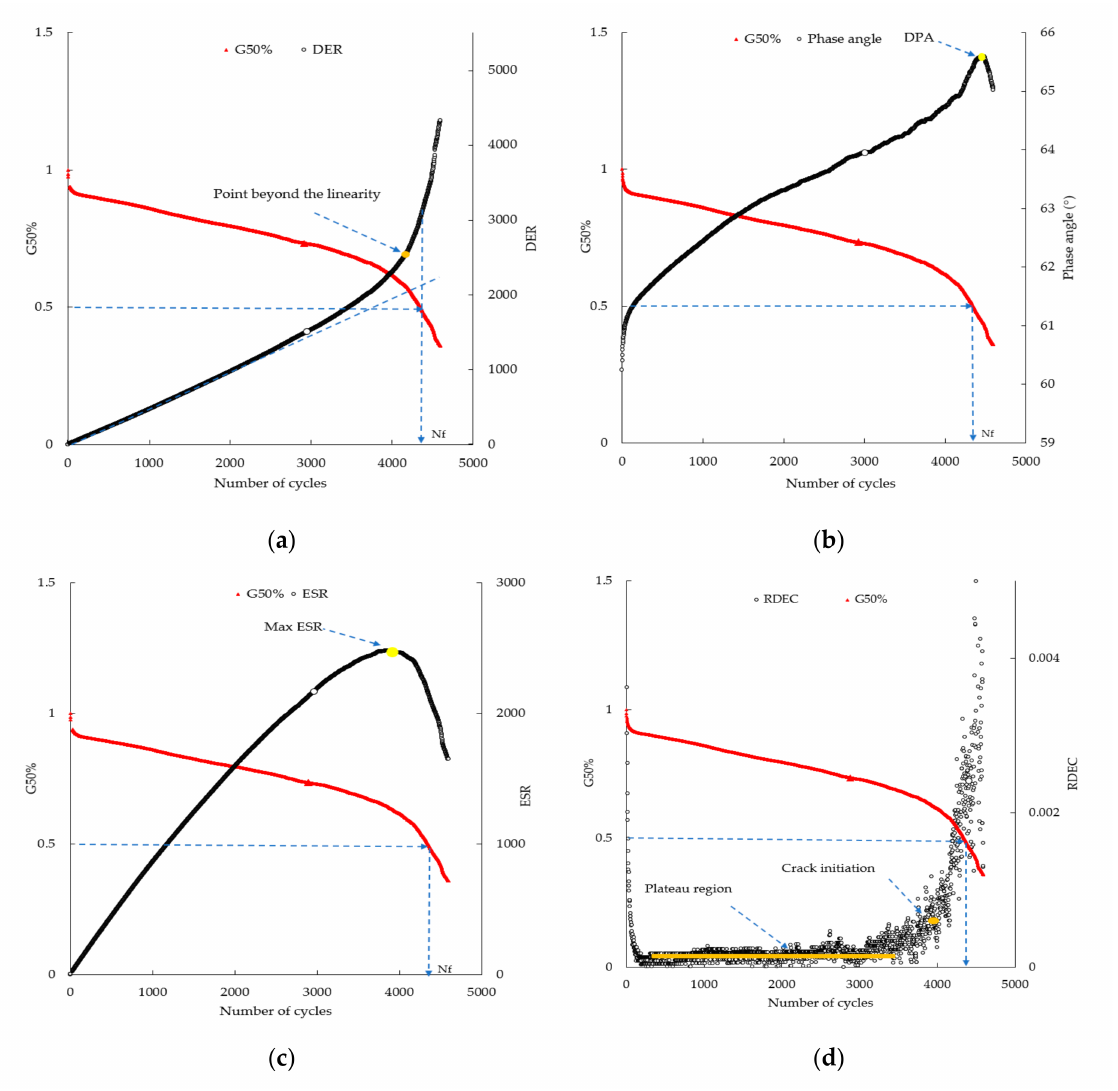
Figure 3. Comparing Nf for various approaches with the G50%: ( a ) Drop In Phase Angle (DPA); ( b ) Dissipated Energy Ratio (DER); ( c ) Ratio of Dissipated Energy Change (RDEC); ( d ) Energy Sti ff ness Ratio